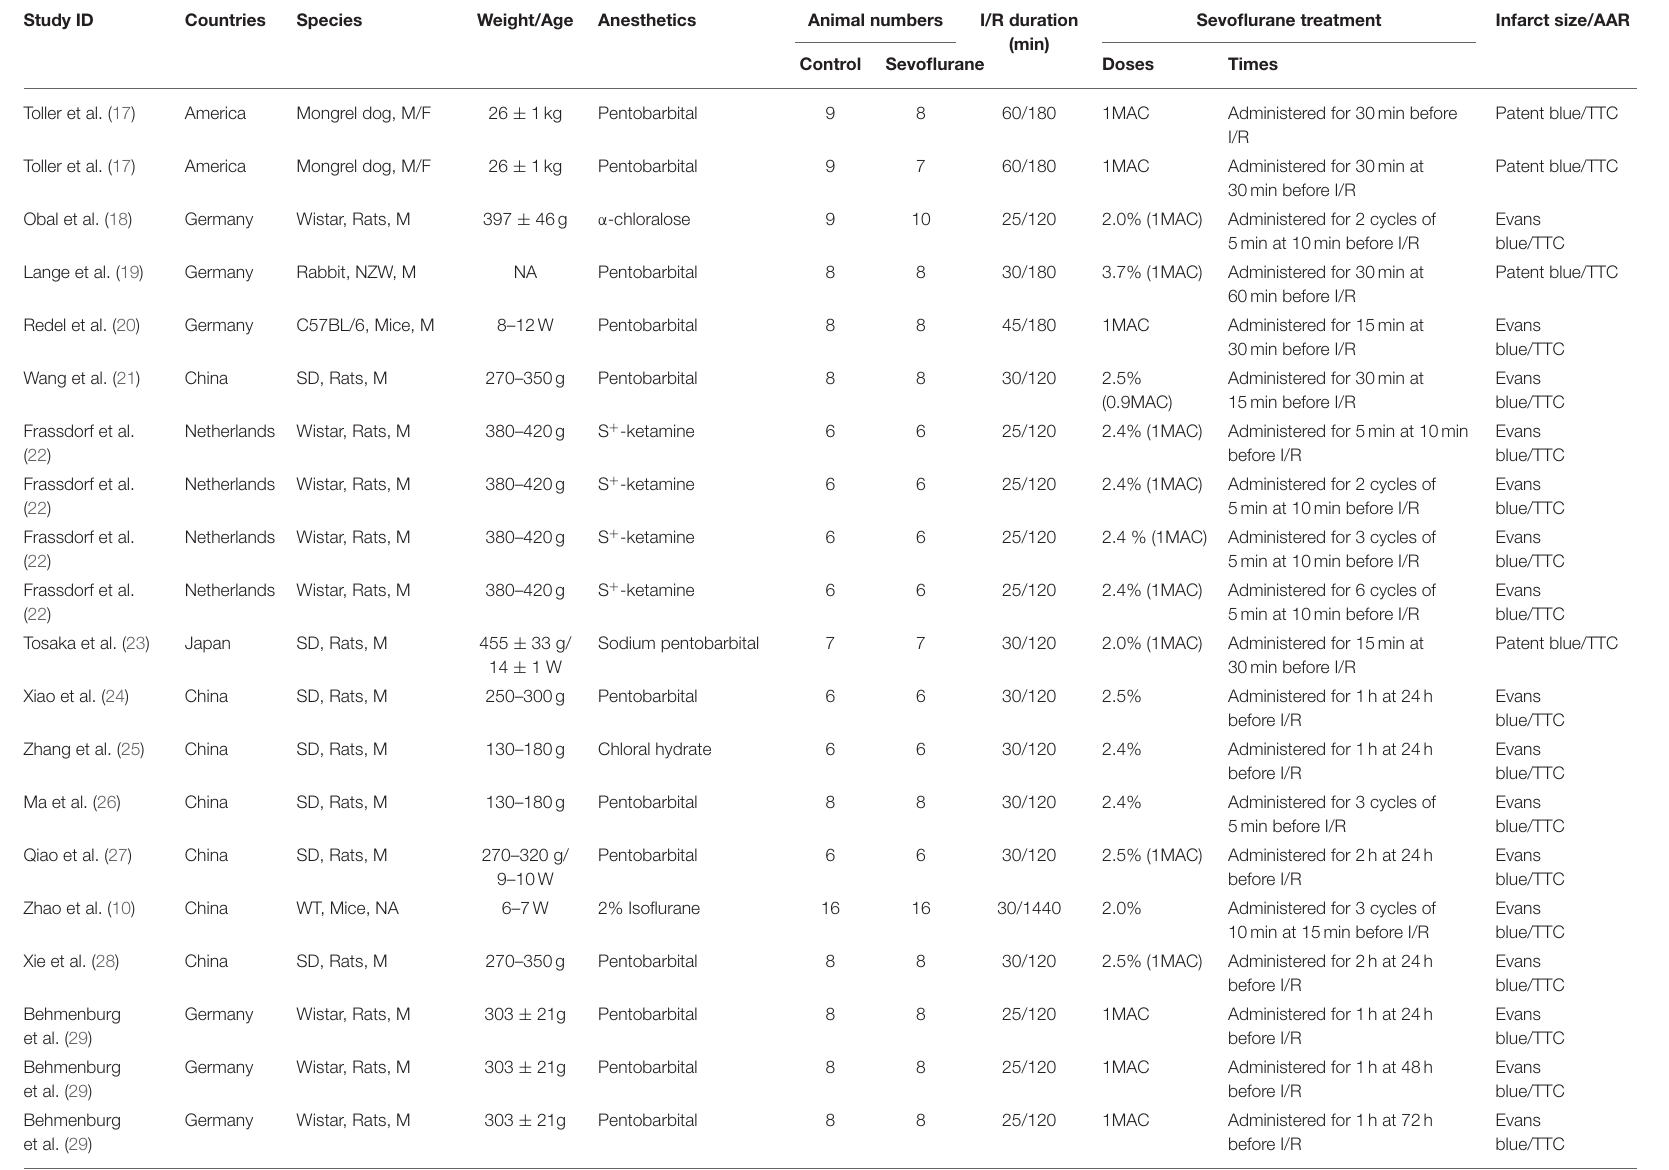
TABLE 1A | The characteristics of sevoflurane preconditioning (SPreC) studies included in the